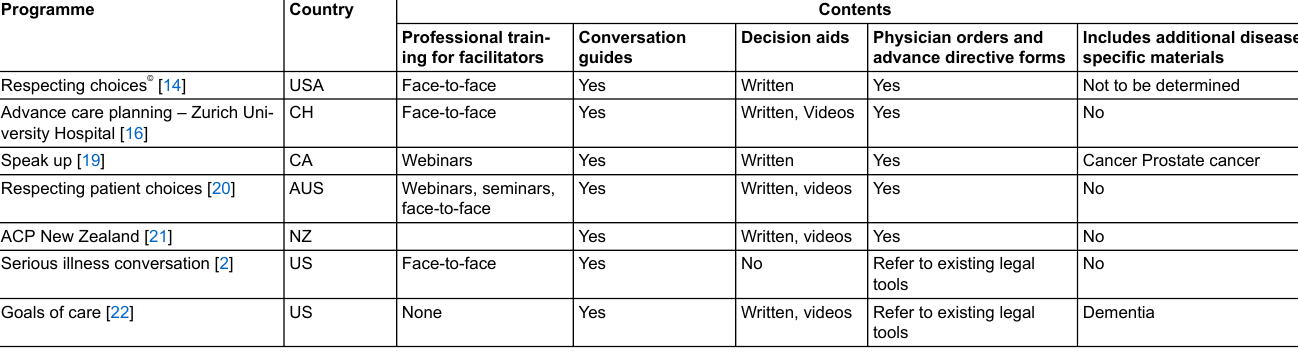
Table 1: Examples of the most widely known and published ACP interventions and documentation in English and German. Programme Country